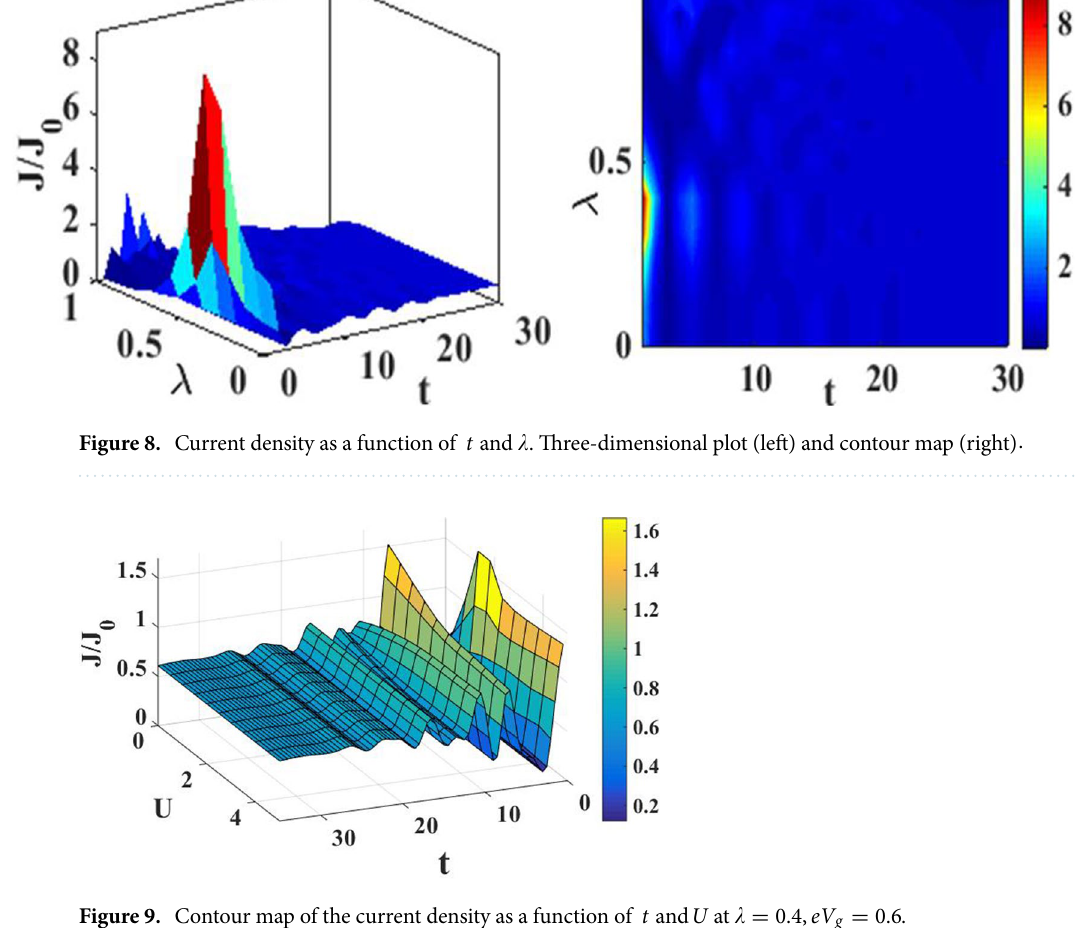
Figure 9. Contour map of the current density as a function of t and U at (cid:31) = 0.4, eV g = 0.6